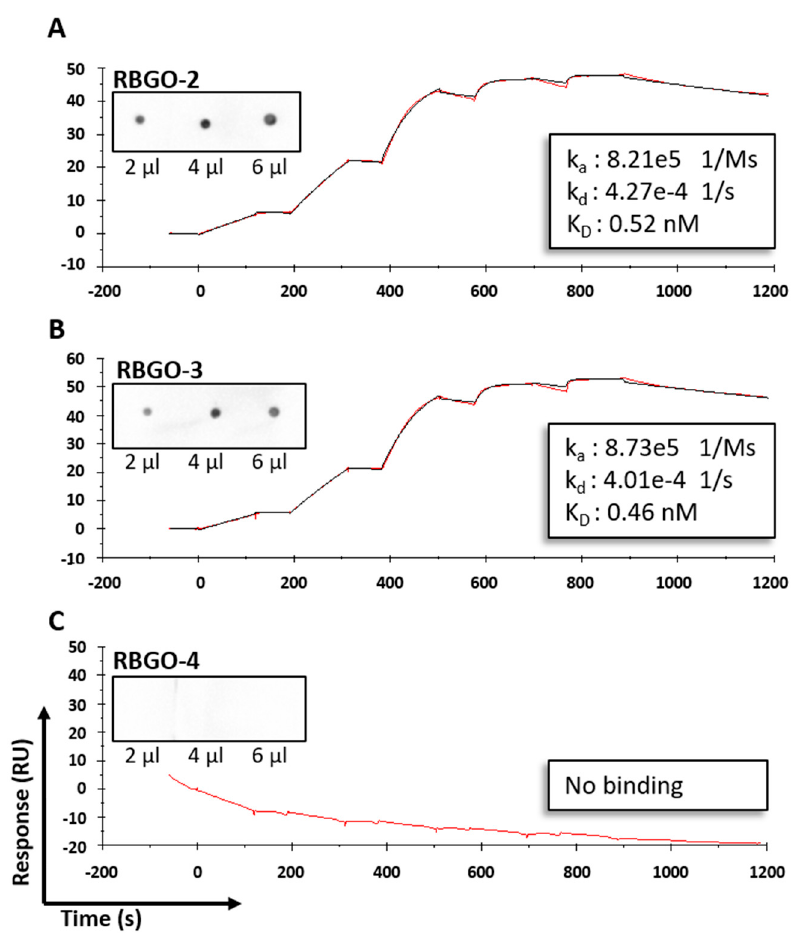
Figure 4. Surface plasmon resonance (SPR) provides an enhanced platform for antibody clone selection. Antibody clones RBGO2 ( A ), RBGO3 ( B ) and RBGO4 ( C ) were assessed for binding kinetics to the immunization peptides used to generate the clones by ELISA. For SPR, antibodies were captured onto a Sensor Chip CM5 via an amine coupled anti-mouse antibody. Single-cycle kinetics experiments were then performed using unconjugated peptides; aa198–217 peptide (RBGO2 and RBGO3; 2.5 to 200 nM) or the aa327–344 peptide (RBGO4; 2.5 to 200 nM). Kinetics were determined using a one-to-one binding model. Curves displayed are exemplar curves from three independent experiments and the data are the mean. Inset images = aa198–217 ( A,B ) or aa327–344 ( C ) were immobilized onto activated PVDF membrane (the volumes displayed at 100 µ g/mL) and probed with each appropriate α -RAGE antibody (1 µ g/mL). Images were acquired using a ChemiDoc™ MP Imaging system and analyzed with Image Lab™ software.